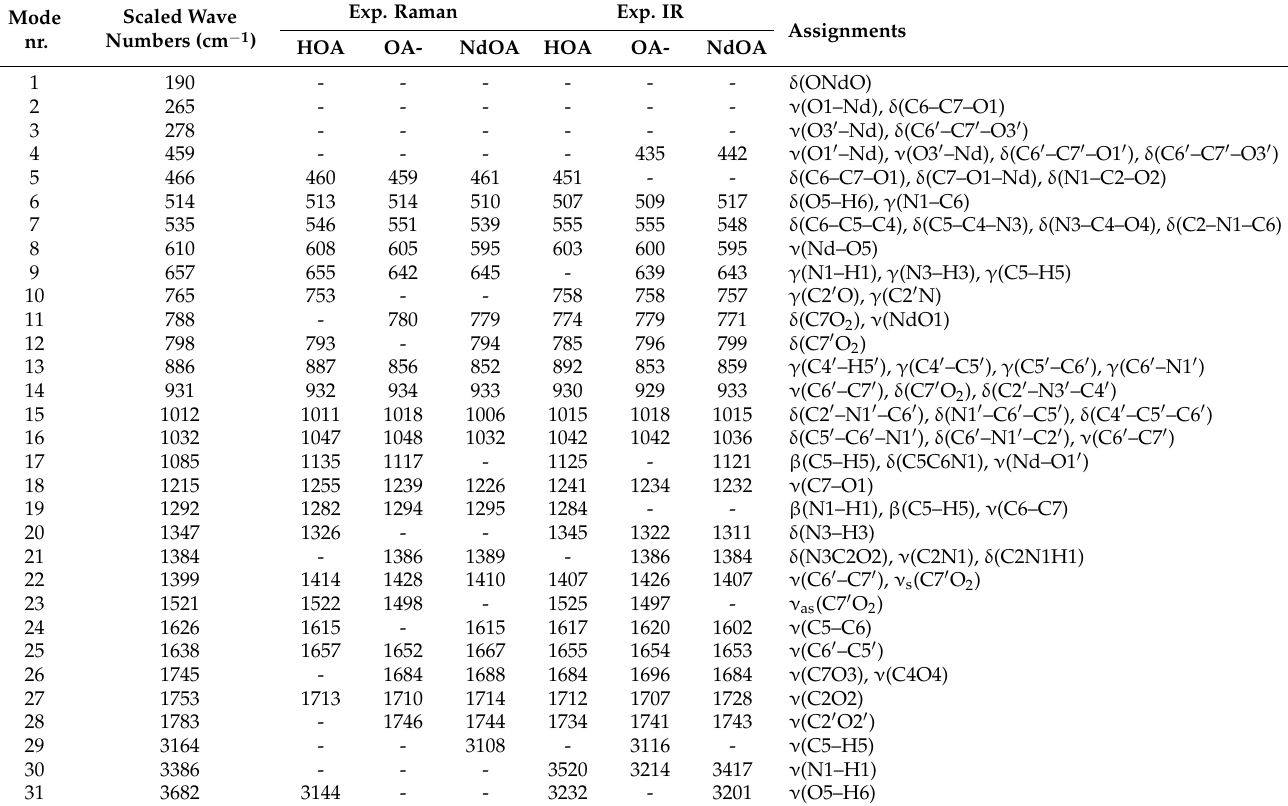
Table 2. Selected theoretical B3LYP-cc-pVDZ(SDD) and experimental IR and Raman wavenumbers (cm − 1 ) of the Nd(III) complex (NdOA), and their tentative assignment. Experimental data for orotic acid (HOA) and its anion (OA − ) are included for comparative purposes. Mode nr.